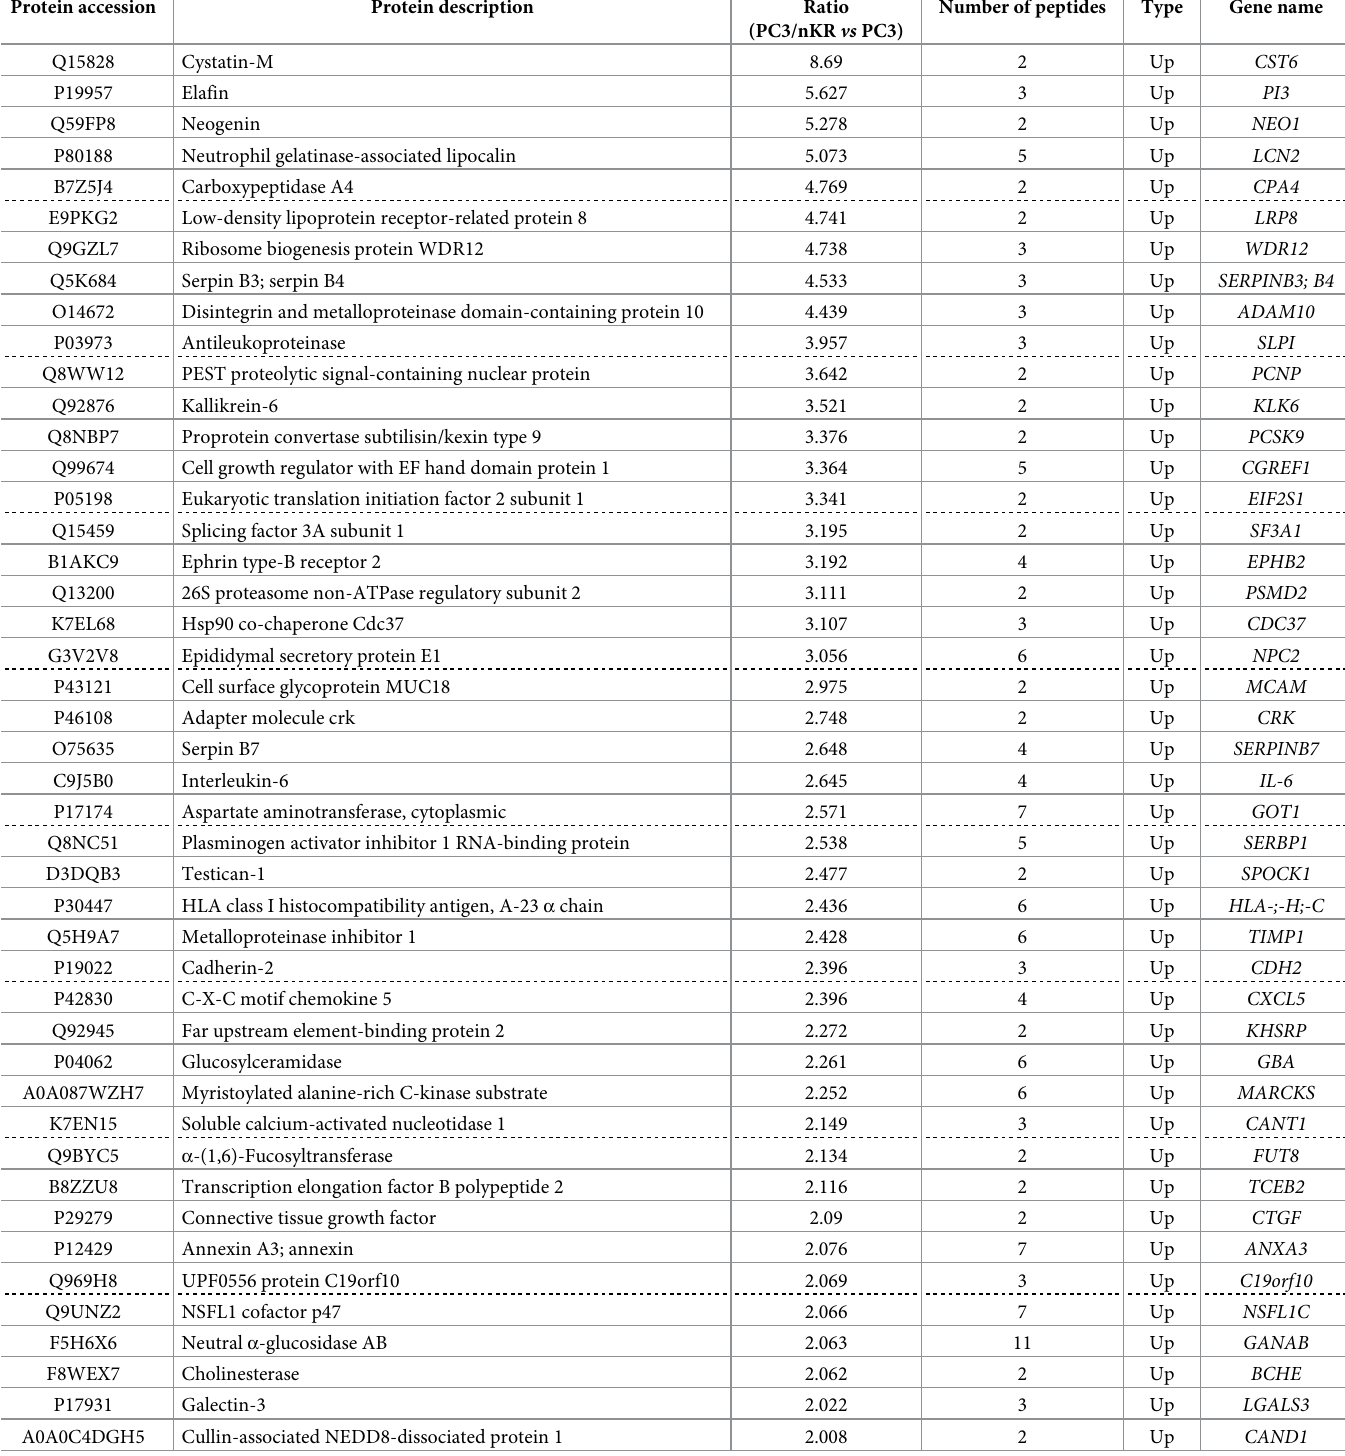
Table 1. List of proteins secreted at higher levels by PC3/nKR cells than by PC3 cells. Protein